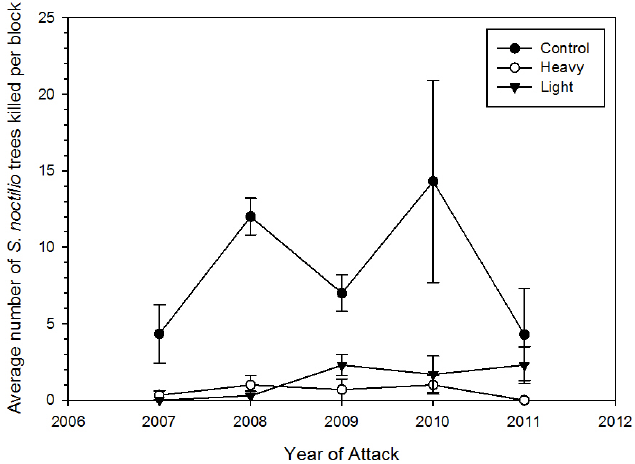
Figure 2. Average (±SE) annual number of Pinus resinosa attacked by Sirex noctilio in control and thinning treatments ( N = 3) over the survey